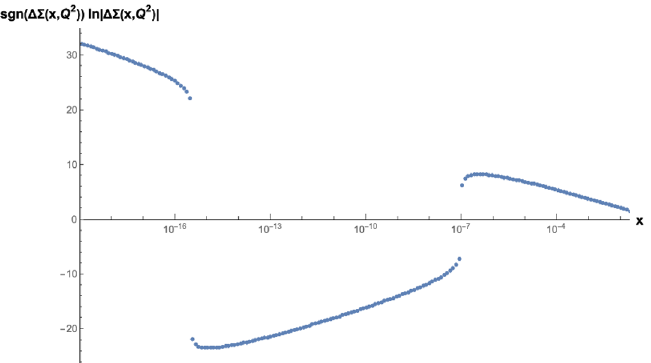
Figure 4 . Plot of sgn[(cid:1)(cid:6)] ln j (cid:1)(cid:6) j versus x resulting from the numerical integration of eq. (4.4) for N f = 3, (cid:11) s = 0 : 25, Q 2 = (cid:3) 2 , and with the step size (cid:1) (cid:17) = 0 :